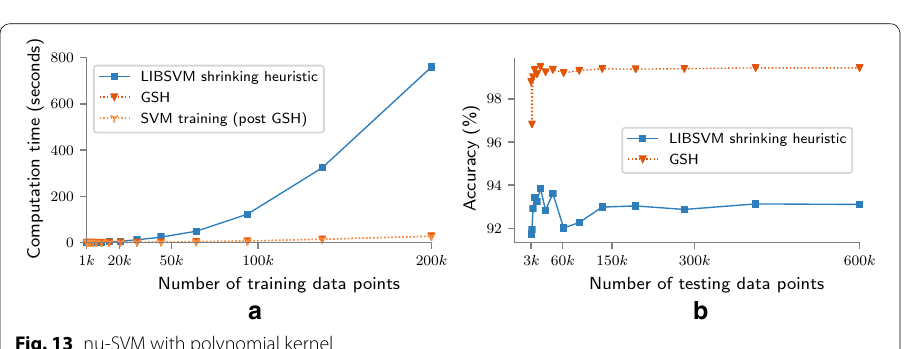
Fig. 13 nu-SVM with polynomial